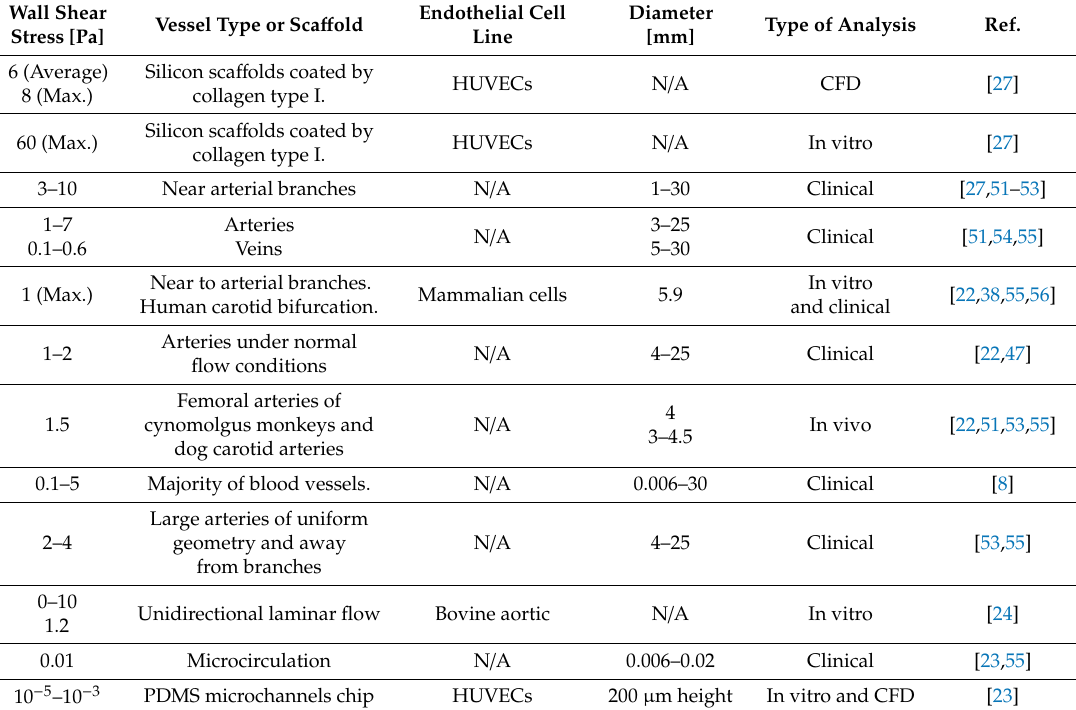
Table 8. Comparison of wall shear stress reported